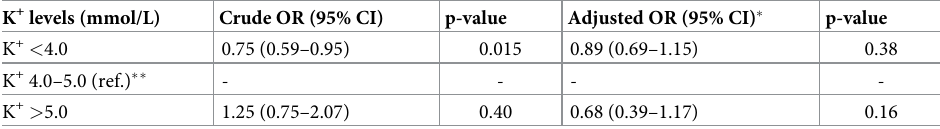
Table 3. Associations between K + levels and the outcome of hospitalization or death.